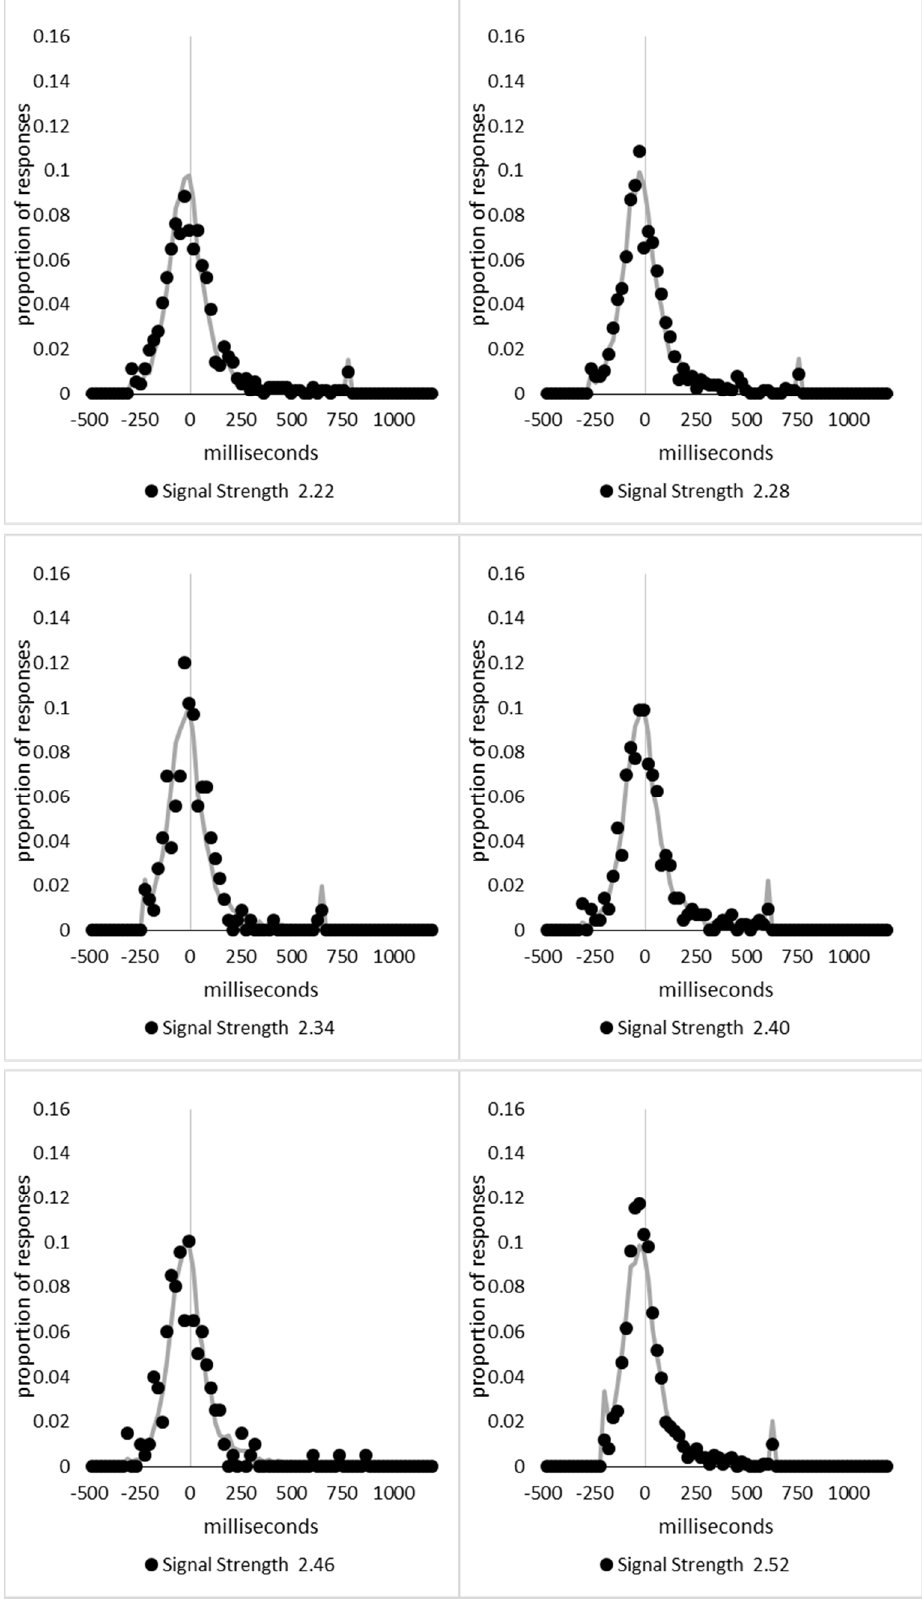
Figure A7. Density functions of the observed data (filled circles) and model (solid line) for signal strength bins 2.22 to 2.52.